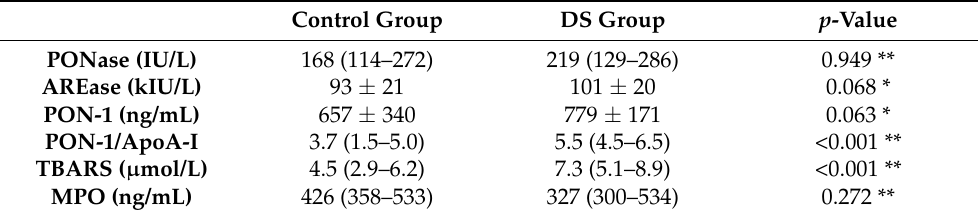
Table 4. Characteristics of the oxidative-stress-related parameters in patients with and without Down